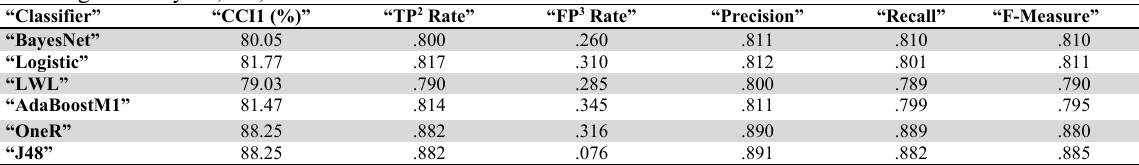
Predicting the IU by PP, PU, and PEOU